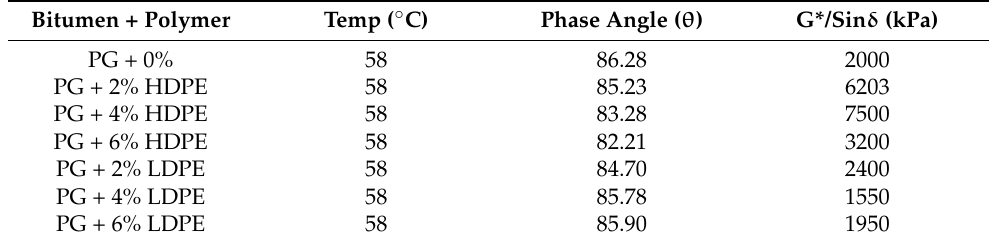
Table 5. RTFO of HDPE and LDPE modified bitumen (PG